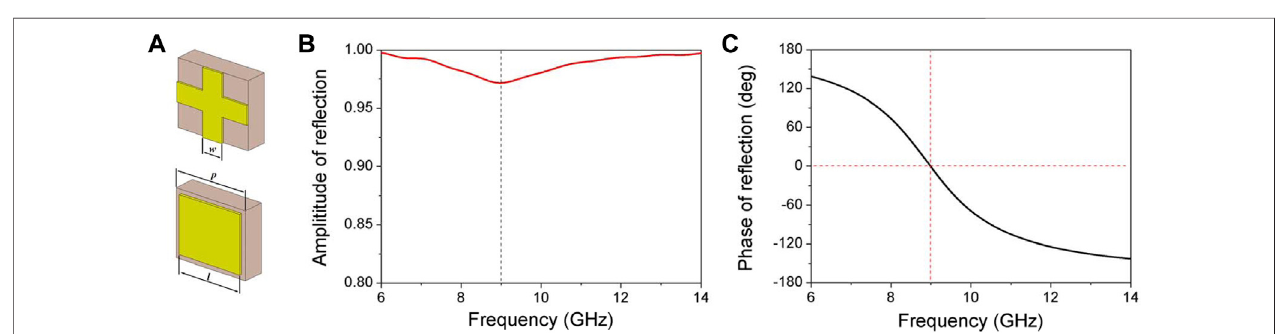
FIGURE 2 | Simulation results of the MNM unit. (A) Schematic diagram of the MNM unit; (B) Simulated re fl ection amplitude. (C) Simulated re fl ection phase.